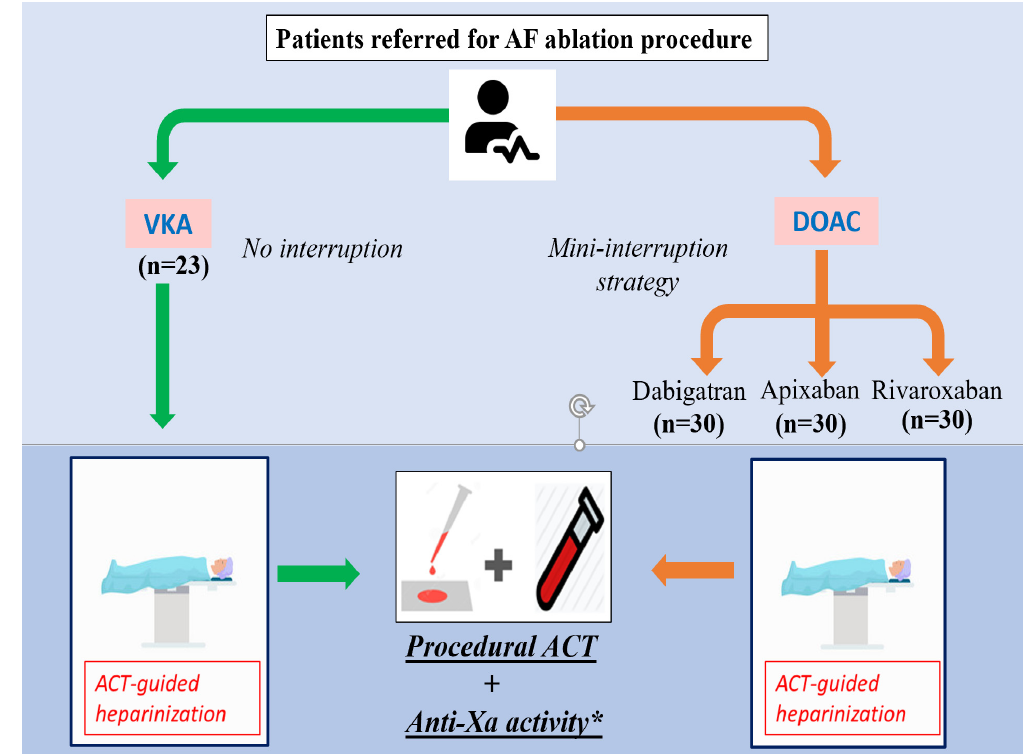
Figure 1. Study design. * DOAC-stop was used for Anti-Xa analyses for patients receiving factor X inhibitors.